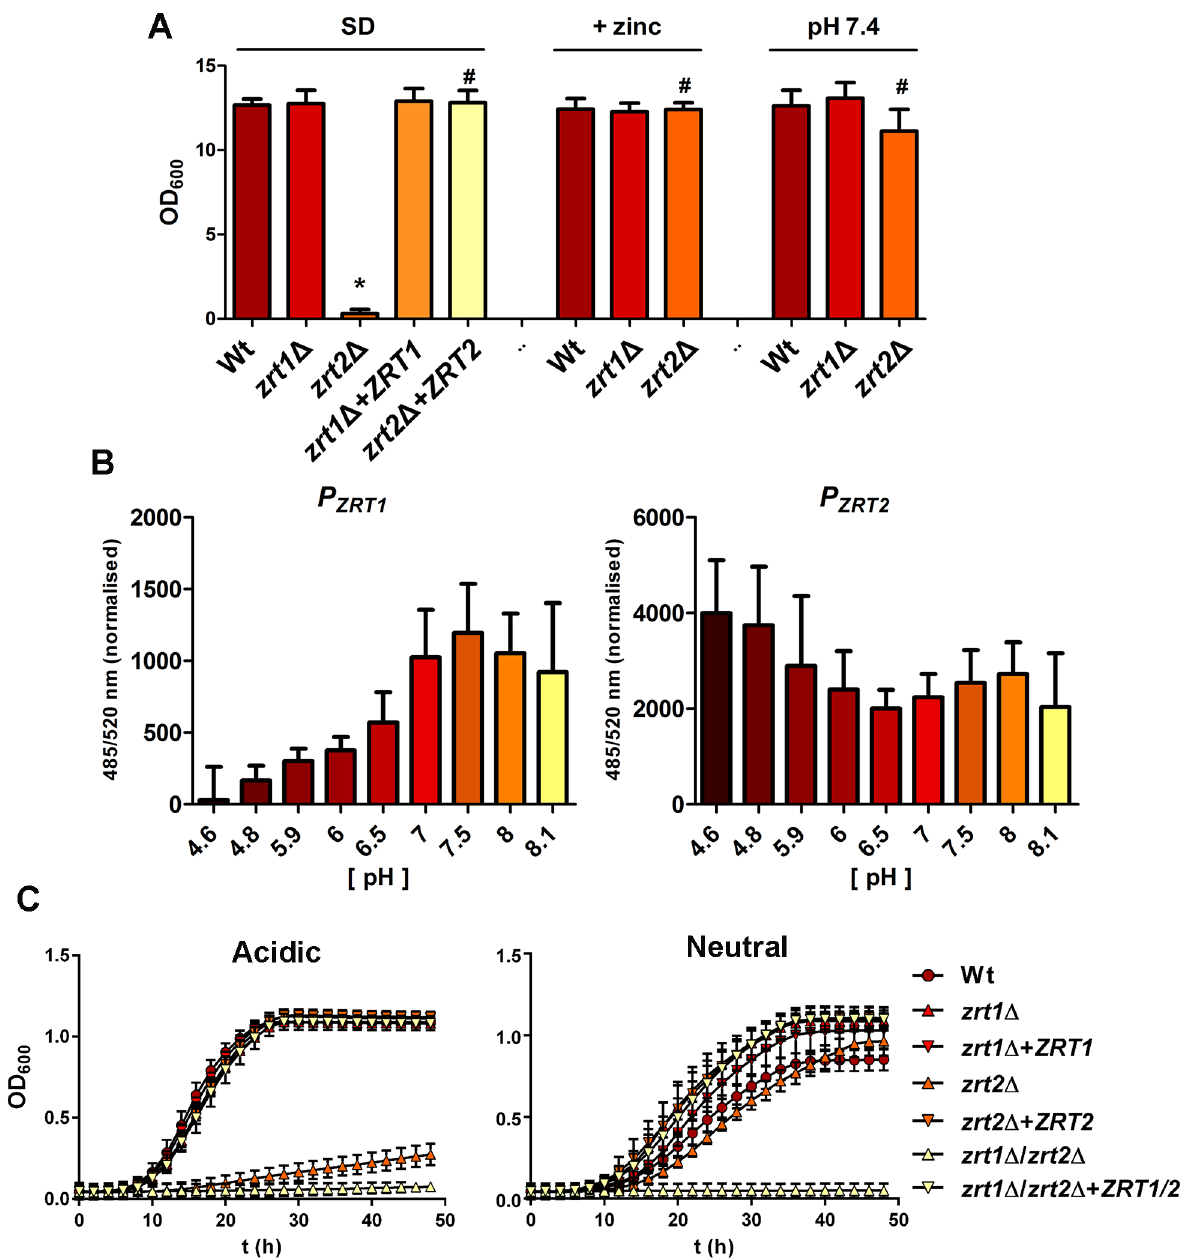
Fig 1. pH-dependent functionality and regulation of Zrt1 and Zrt2 in C . albicans . ( A ) Zrt2 is essential in acidic medium. Indicated strains, precultured in YPD, were washed and cultured in SD (YNB+glucose) medium alone, or supplemented with 100 μM ZnSO4 or with 50 mM HEPES pH 7.4. Asterisks indicate statistical significance compared to the wild type; # indicates statistical significance compare to the zrt2 Δ in SD; P < 0.05. ( B ) ZRT1 promoter activity is pH regulated and ZRT2 is constitutively expressed under zinc limitation. ( P in LZM buffered to indicated pH values). LZM was used due to lower green autofluorescence. Experiment performed three times. ( C ) Double deletion of ZRT1 and ZRT2 precludes growth at both acidic and neutral alkaline pH. Strains were cultured as in (A) and growth kinetics measured over 48 h in a microtitre plate. Experiment performed twice in